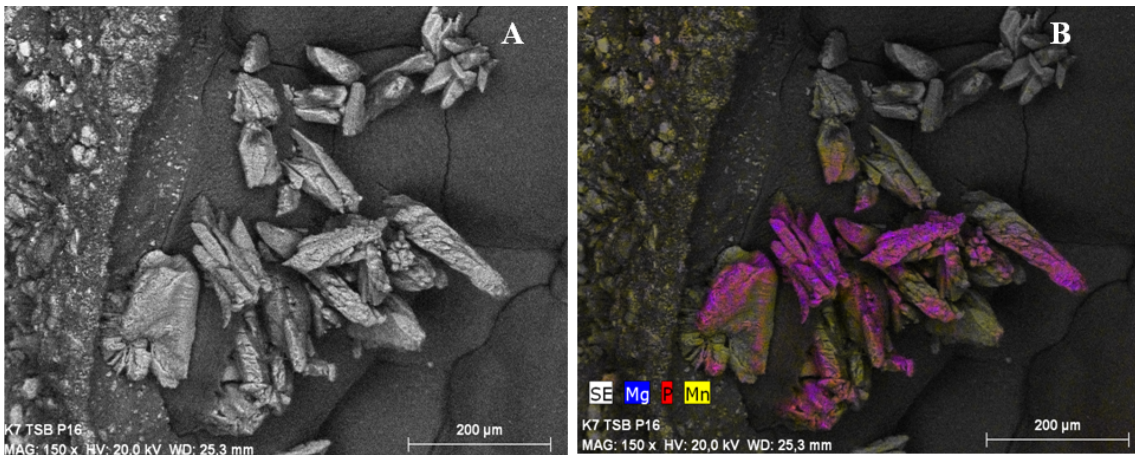
Fig. 3. Struvite crystals on the colony surface of S. mirabilis P16B-1: back scatter image (A) ; corresponding element mapping (B) : blue, Mg; red, P; yellow, Mn; derived color, elements corresponding to respective fast